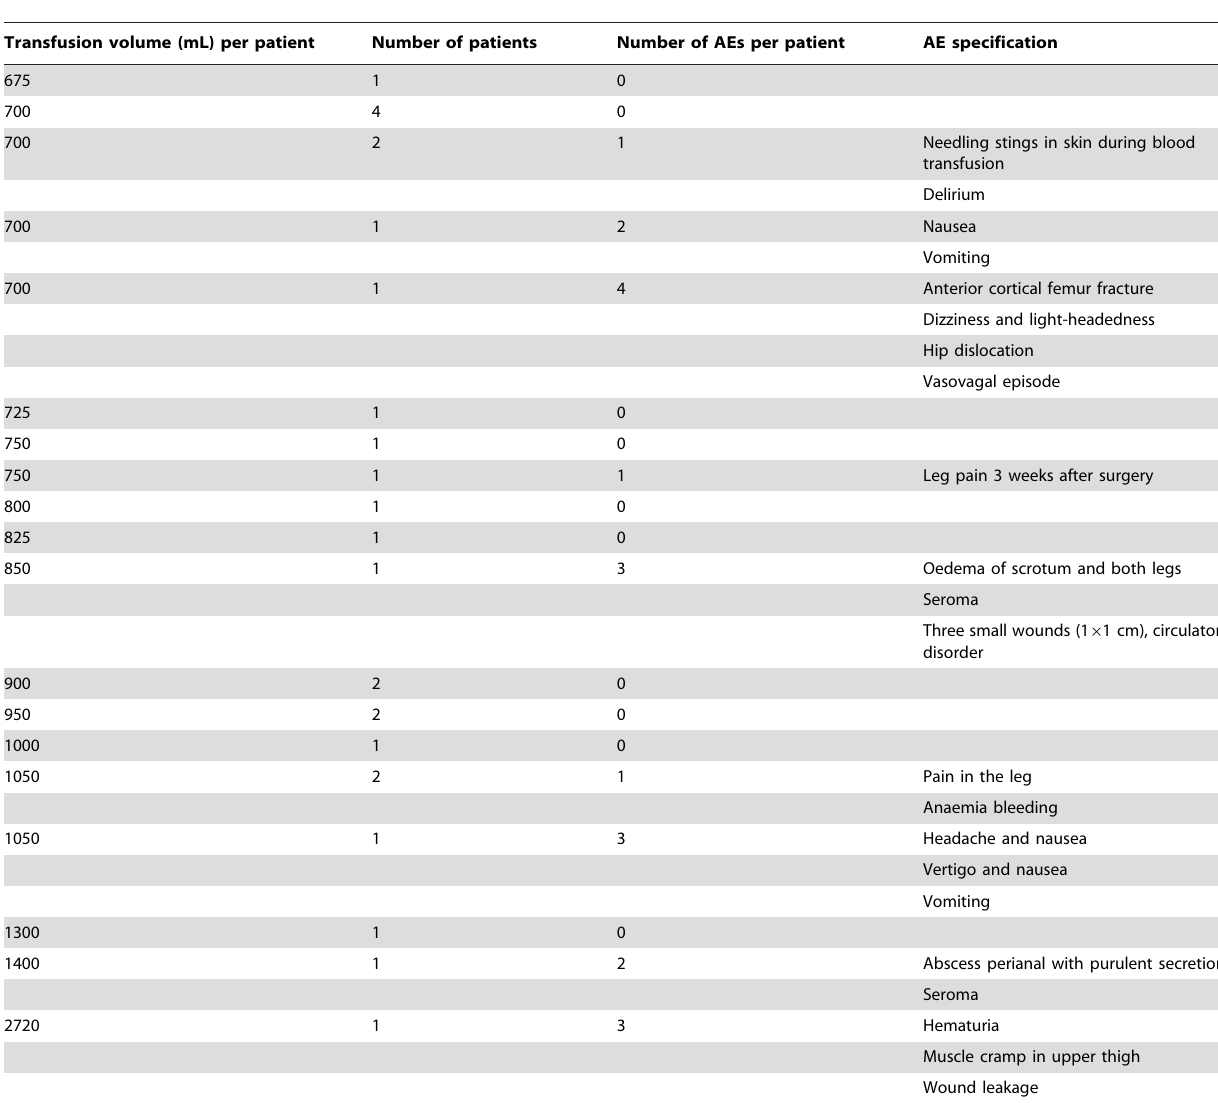
Table 6. Reported adverse events for Sangvia group with autologous transfusion volume . 669 mL 1